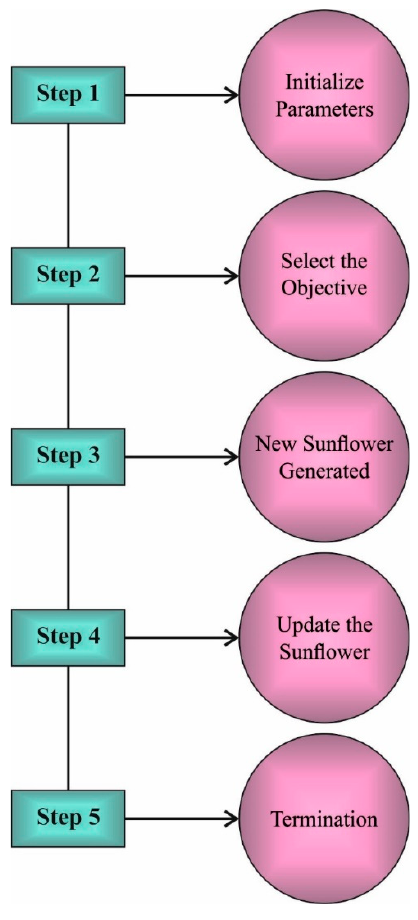
Figure 3. Flowchart of SFO.